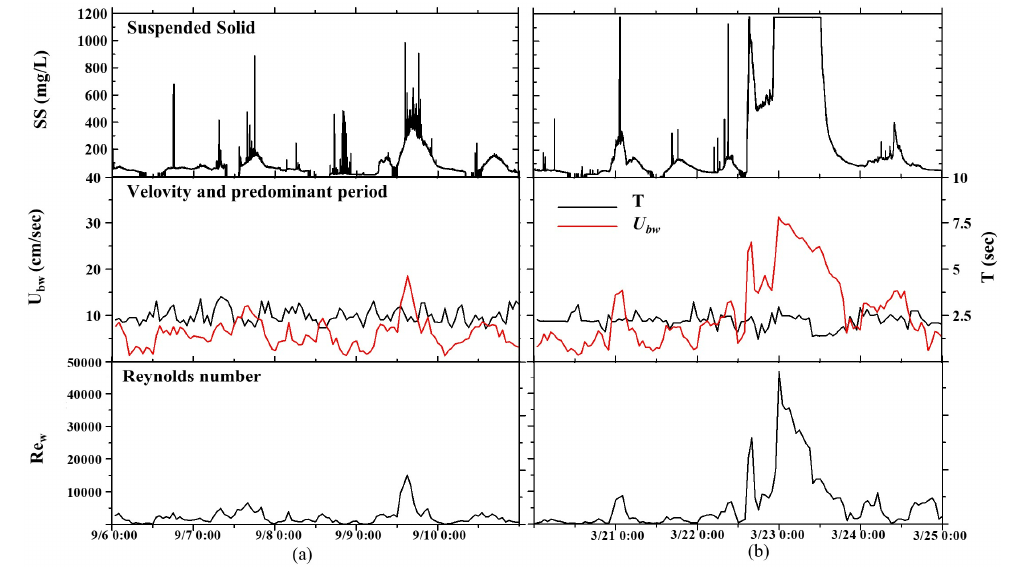
Figure 19. Results of the field observations: ( a ) September 2015 ( b ) March 2016. The relationships between the Reynolds number and SS obtained from the results of field observations were shown as x marks in Figure 18. Those were on the same linear line as the results of the laboratory experiment. It is considered that the formulation of the relationship between the Reynolds number and SS in the laboratory experiment can reproduce the state of resuspension driven by wind in the